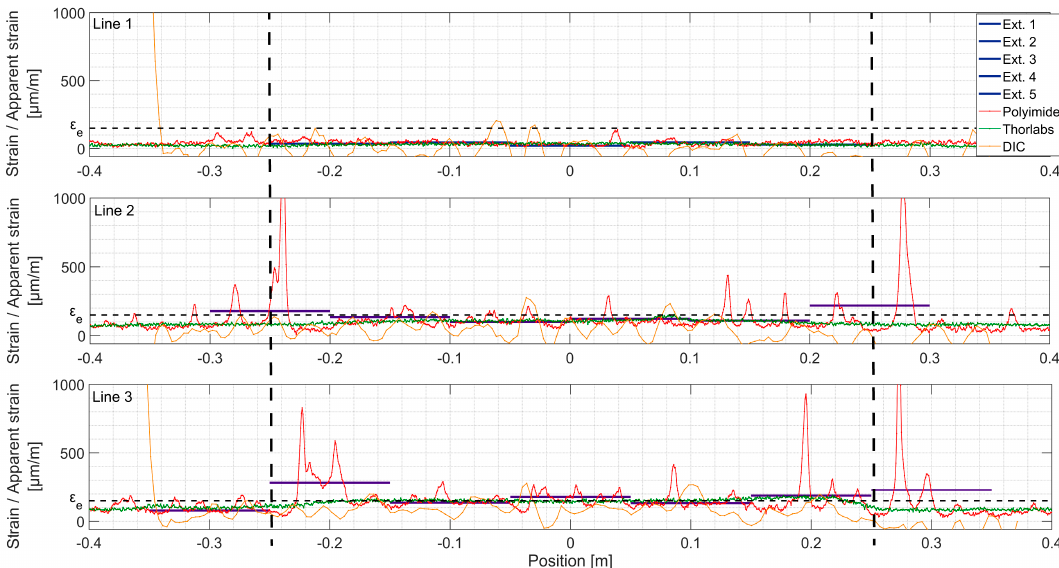
Figure 11. Strains measured with different techniques, load step 2, F = 50 kN; the constant bending moment zone is marked with dashed lines.